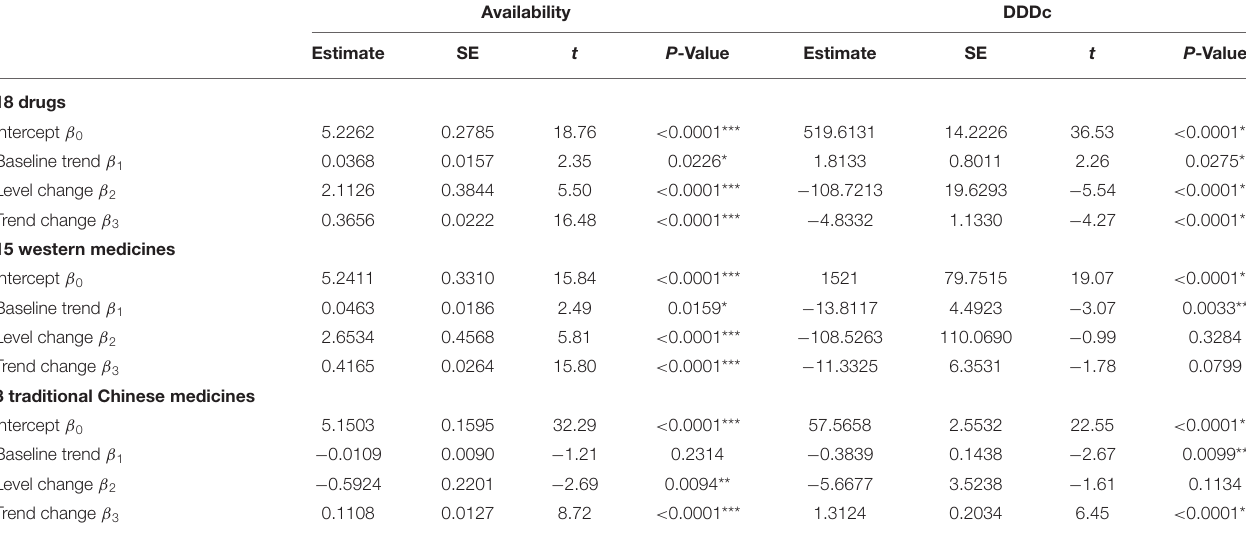
TABLE 3 | ITS results of the impacts of NRDLN on monthly availability and DDDc for all 18 drugs, with a breakdown for the 15 Western Medicines and 3 Traditional Chinese Medicines (2015–2019). Availability